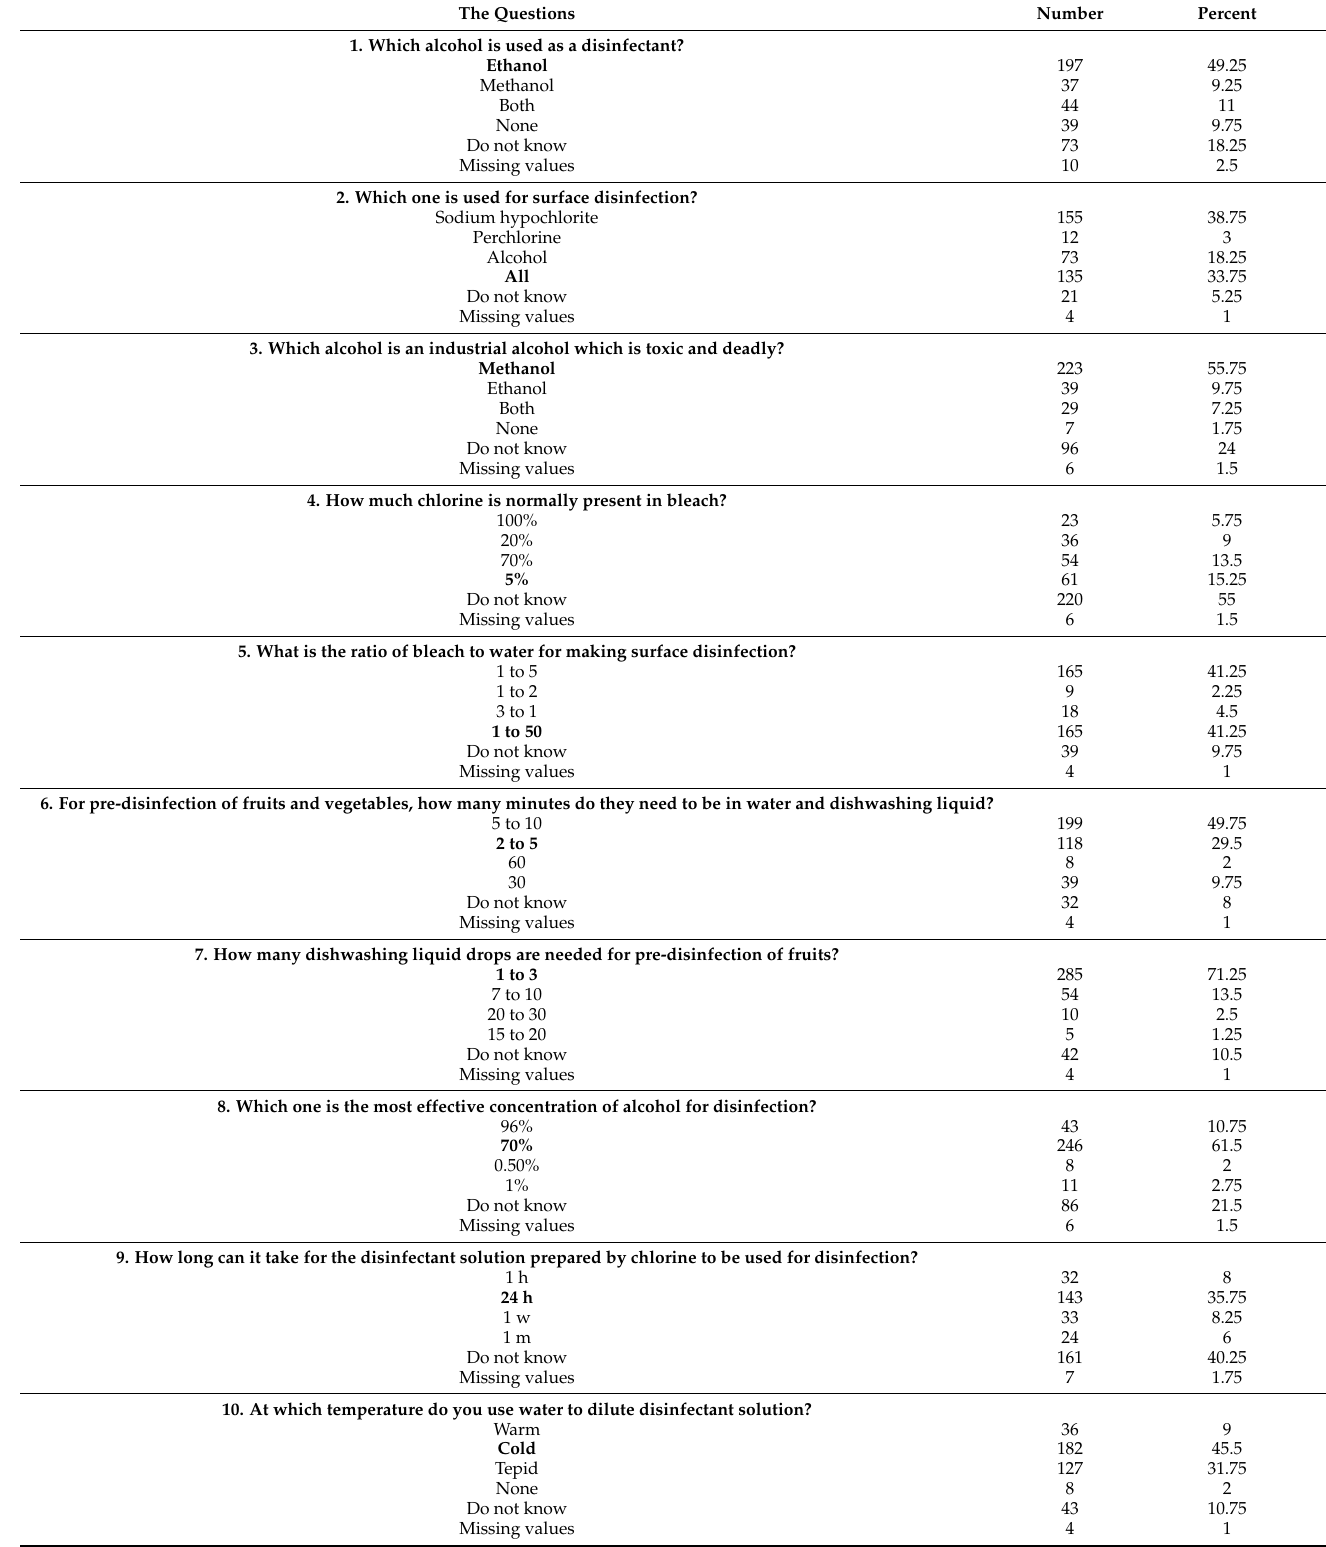
Table 2. Distribution of responses relating to